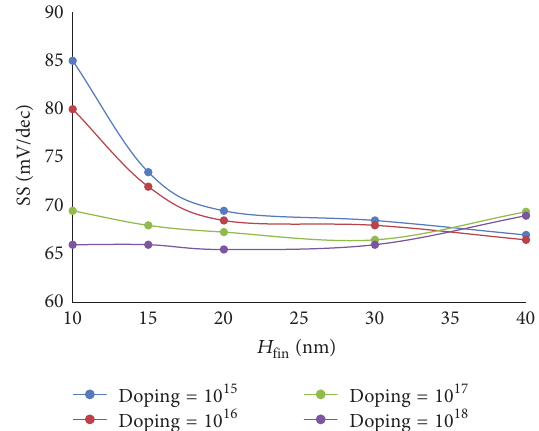
Figure 7: Variation of SS with fin height for different doping concentration at 1nm oxide thickness.